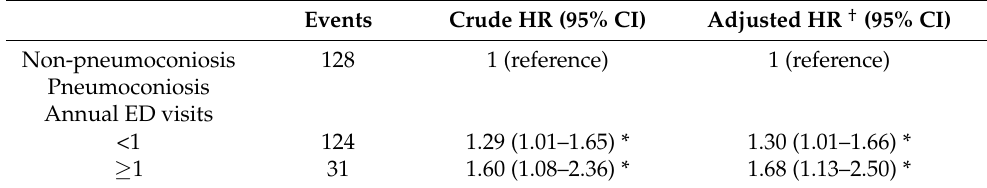
Table 4. Events and hazard ratios of acute myocardial infarction associated with mean number of annual emergency department visit for participants with pneumoconiosis compared with those without